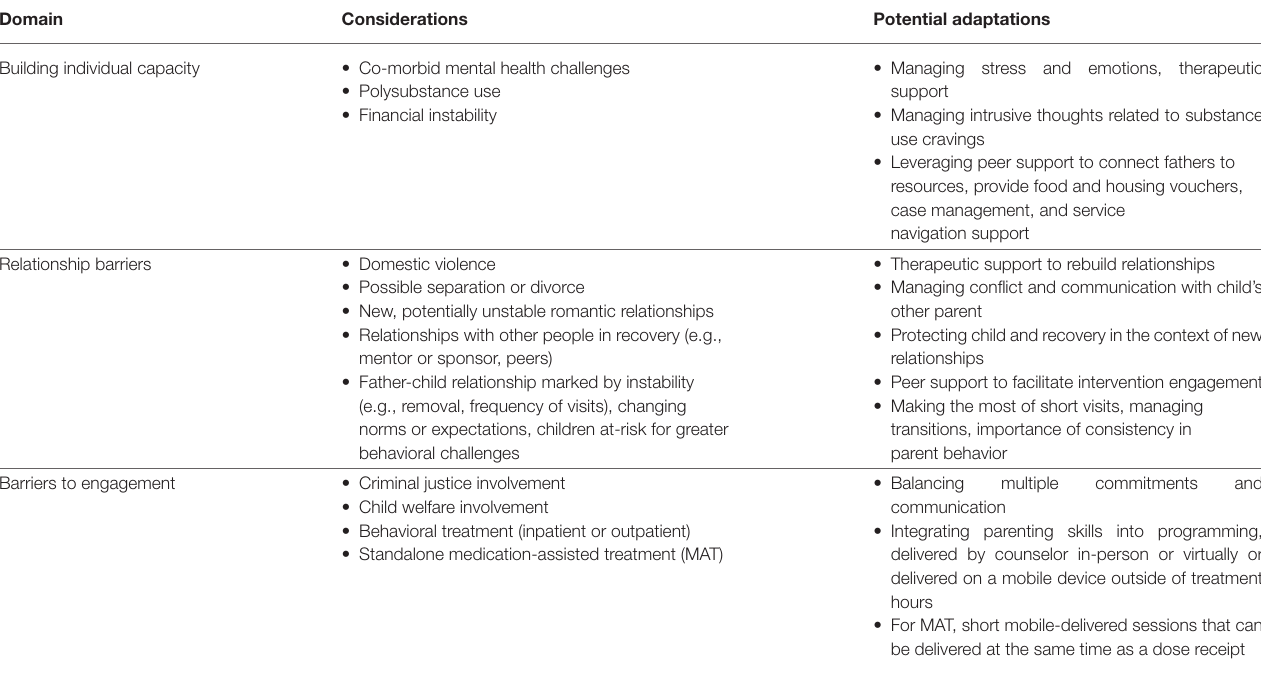
TABLE 1 | Parenting intervention adaptations for father who misuse opioids.